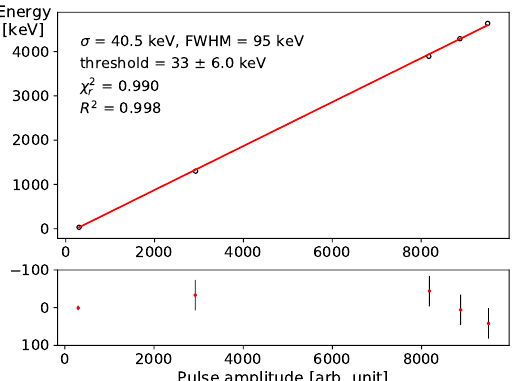
Figure 5. Calibration curve for the reference α -source, fitting the simulated energy peaks to the pulse amplitudes in the recorded histogram. The lower difference plot shows the deviations of the pulse amplitude data from the linear fit including error-bars. The standard deviation is derived from the FWHM value which was used to link the AASI simulation with the recorded data: σ ≈ FWHM/2.355.